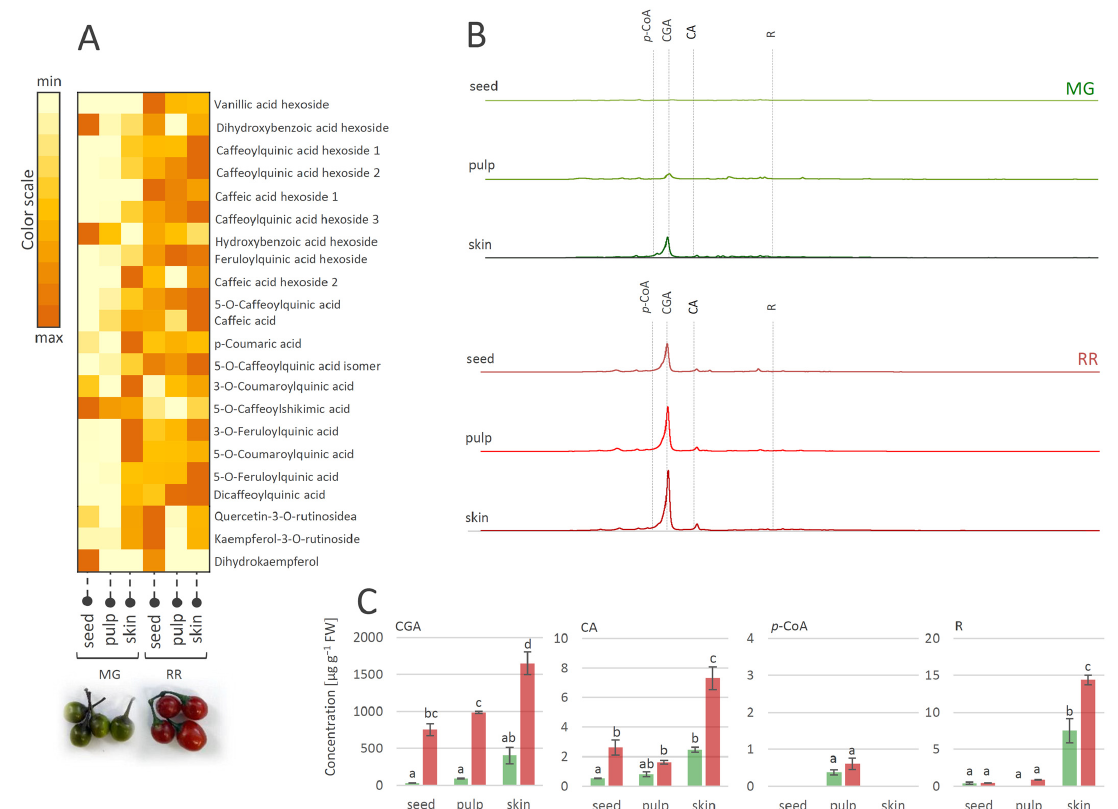
Figure 3. ( A ) Heat-map presenting relative amounts of polyphenolics in different tissues of mature green (MG) and ripe red (RR) bittersweet fruits, as analyzed by UHPLC/LTQ Orbitrap MS n . Color scale indicates values representing peak areas of compounds, distributed between min and max values among tissues, for each compound individually. ( B ) UHPLC/DAD chromatograms of MeOH extracts of seed, pulp, and skin of MG and RR fruits are presented, acquired at λ 260 nm. ( C ) UHPLC/( )HESI ‐ MS 2 quantitative analysis of major phenolic acids in MG and RR fruits. Letters above the bars denote significant differences according to Tukey ’ s pairwise test at p ≤ 0.05. Abbreviations: CGA—chlorogenic acid (caffeoylquinic acid); CA—caffeic acid; p ‐ CoA— p ‐ coumaric acid; R ‐ rutin.